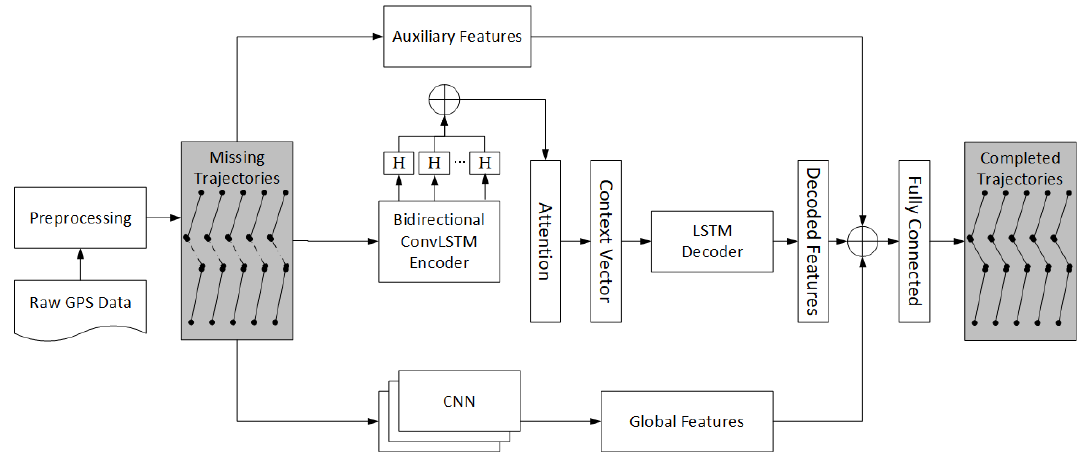
Figure 4. Proposed approach architecture for trajectory